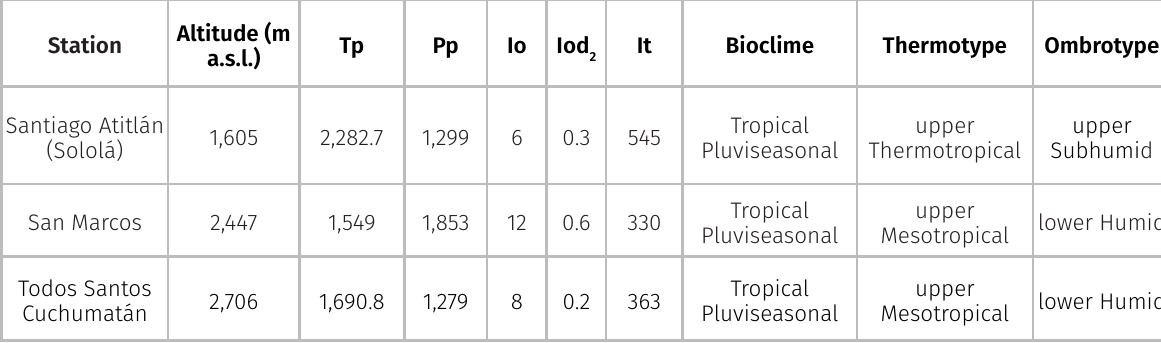
Table I. Summary of the bioclimatic data for the three meteorological stations studied. Abbreviations: Tp (Positive Temperature). Pp (Positive Rainfall). Io (Ombrothermal Index). Iod2 (Ombrothermal Index of the driest bimester of the driest trimester of the year). It (Thermicity